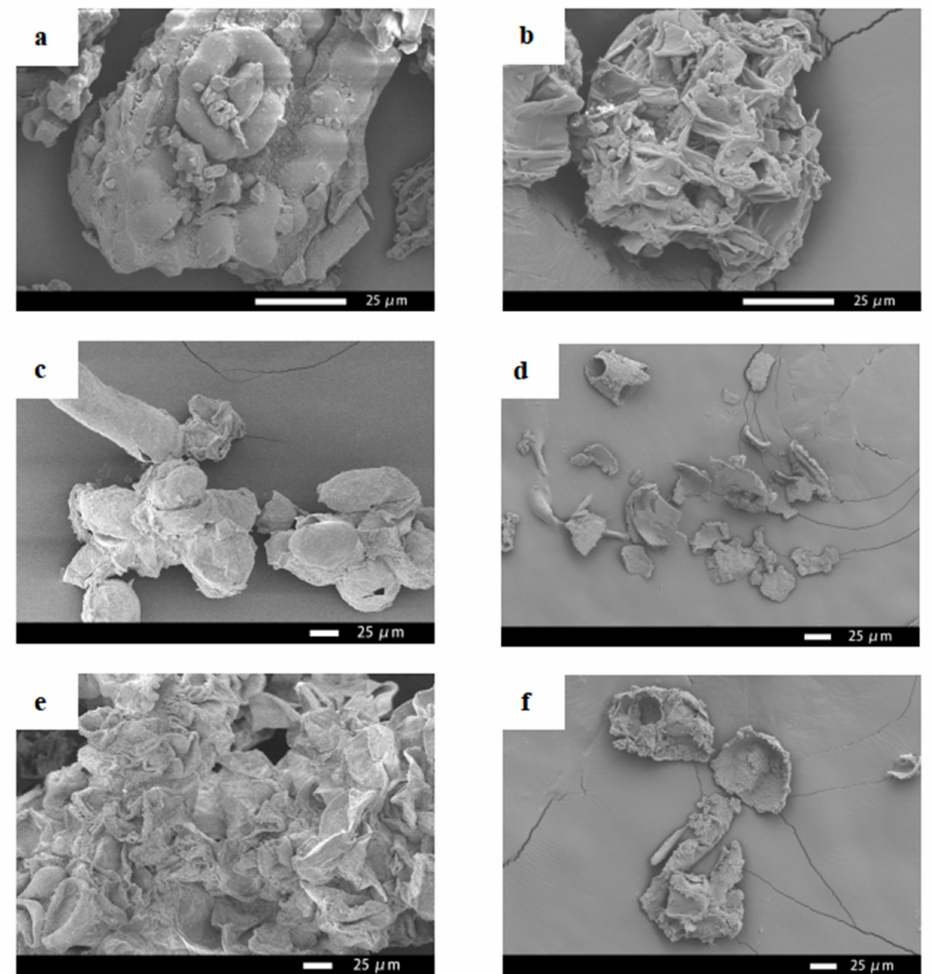
Figure 6. SEM images of Taxus cuspidata needles, callus and suspension cells: ( a ) Taxus cuspidata nee- dles, ( b ) the needles of Taxus cuspidata after ultrasonic extraction, ( c ) suspending cells, ( d ) suspension cells after ultrasonic extraction, ( e ) callus, ( f ) callus after ultrasonic